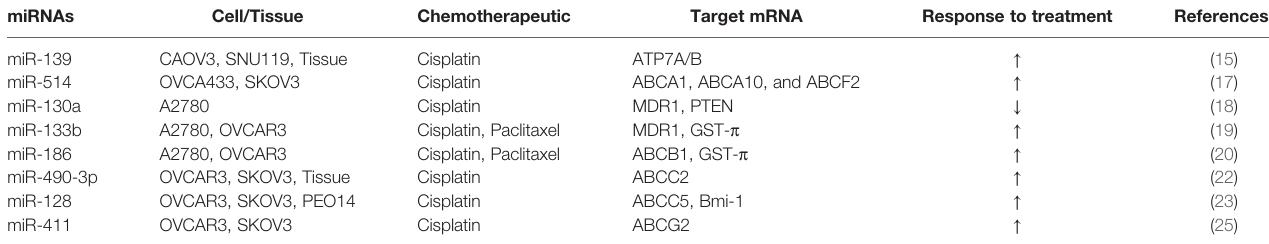
TABLE 1 | miRNAs mediate platinum resistance via regulating intracellular accumulation in OC.